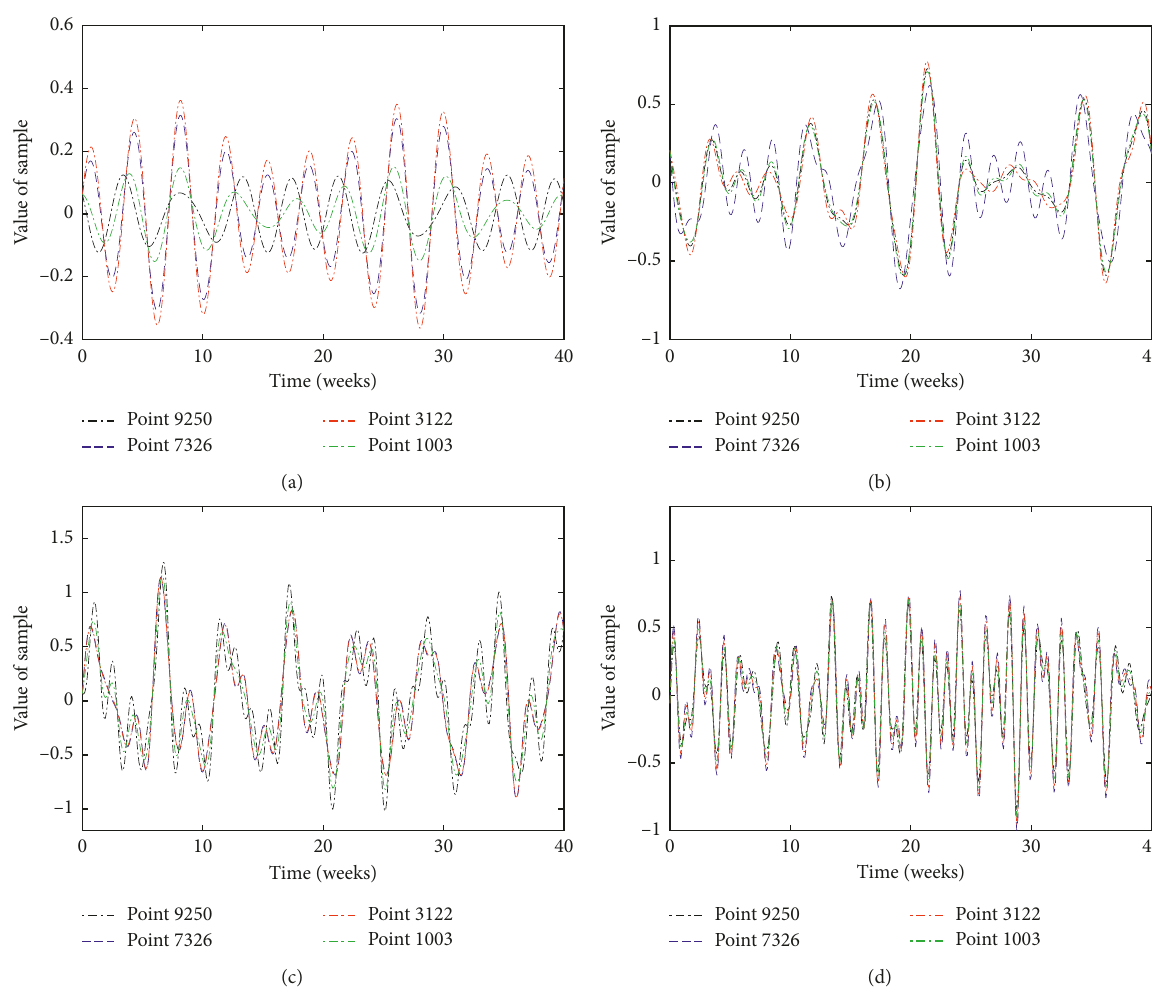
Figure 5: Samples of colored Gaussian noises with the correlation times of (a) 4 weeks, (b) 2 weeks, (c) 0.5 weeks, and (d) 0.2